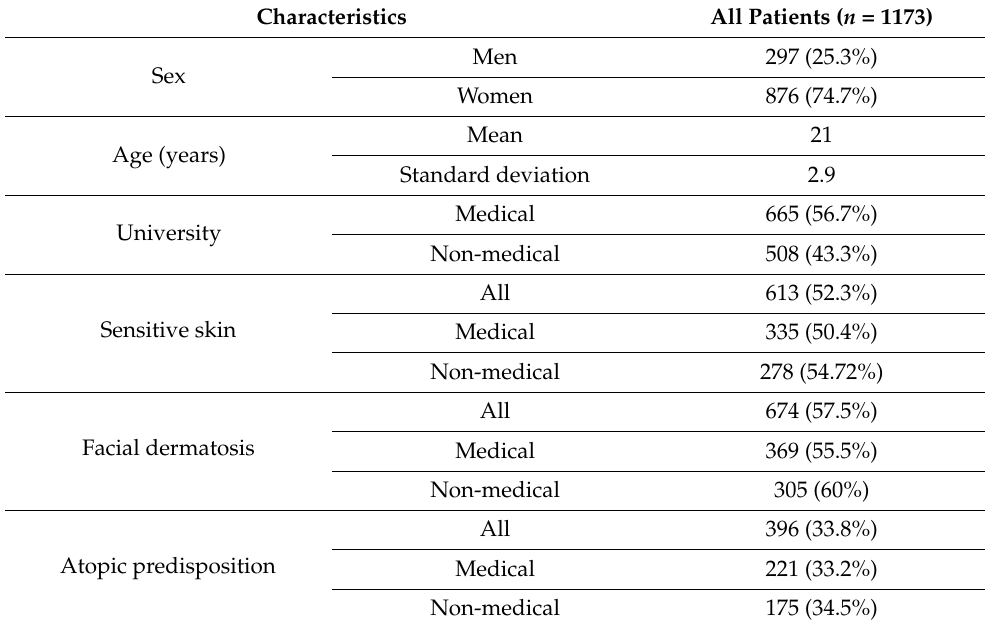
Table 2. Group characteristics.